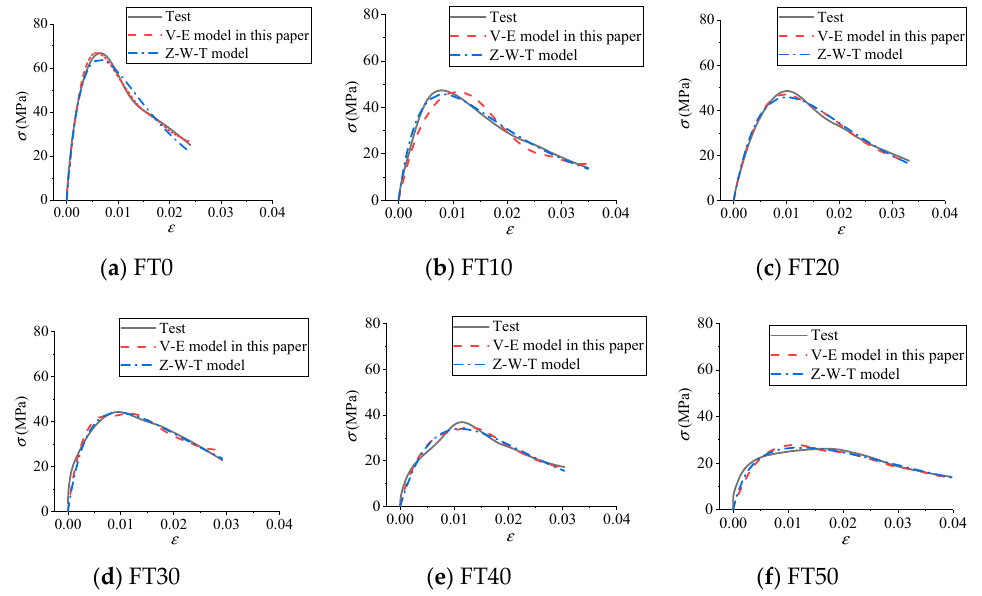
Figure 13. Comparison results of constitutive model curves under impact velocity of 8.8 m / s. ( a )